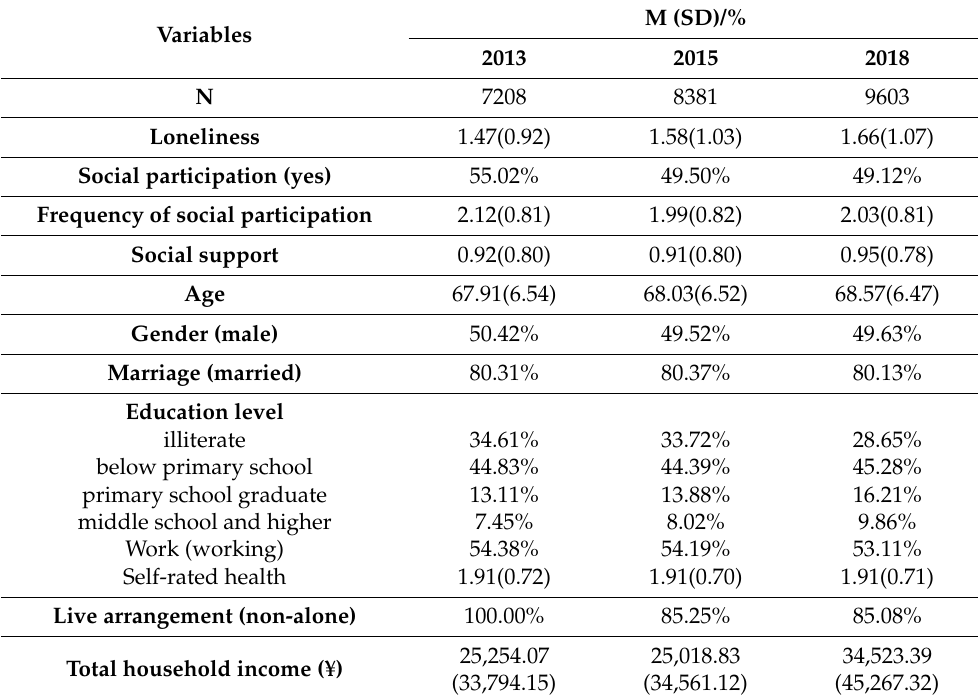
Table 3. Descriptive statistical characteristics of Chinese older